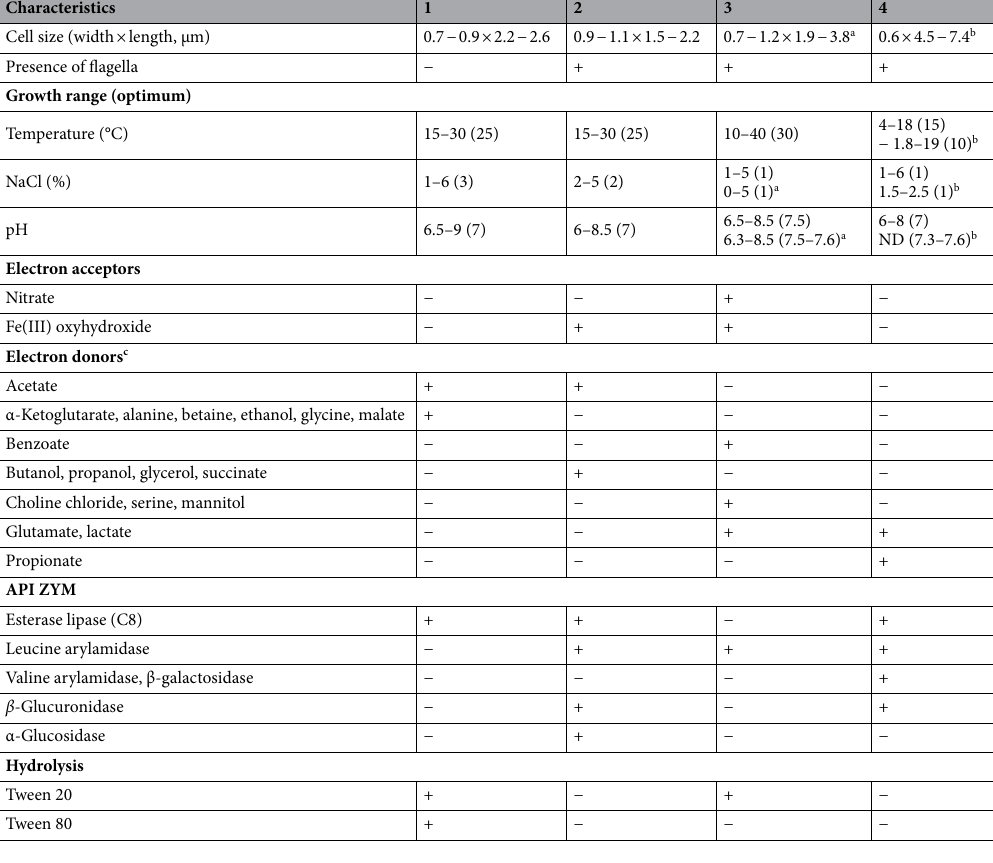
Table 2. Differential phenotypic characteristics of IMCC35004 T , IMCC35005 T , and the type strains of the related genera. Strains: 1, IMCC35004 T ; 2, IMCC35005 T ; 3, Desulfopila aestuarii DSM 18488 T ; 4, Desulfotalea psychrophila DSM 12343 T . All the data are from this study unless otherwise indicated. All the strains are positive for reduction of sulfate, sulfite, thiosulfate, Fe(III) citrate and Mn(IV) oxide; production of H 2 S; catalase; utilization fumarate; alkaline phosphatase, esterase (C4), trypsin, acid phosphatase, and naphthol-AS- BI-phosphohydrolase. All the strains are negative for reduction of nitrite; utilization of butyrate or methanol; oxidase; lipase (C14); cystine arylamidase; α -chymotrypsin; α -galactosidase; β -glucosidase; N -acetyl- β - glucosaminidase; α -mannosidase; α -fucosidase; and hydrolysis of DNA, casein, CM-cellulose, and chitin. +, positive; –, negative, ND; no data. a Data from Suzuki et al. 16 . b Data from Knoblauch et al. 15 . c Ethanol, butanol, and propanol were adjusted to 0.02%, benzoate was adjusted to 5 mM and other carbons to 20